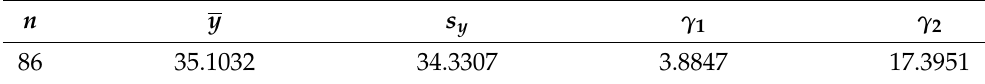
Table 6. Summary statistics for neodymium concentration